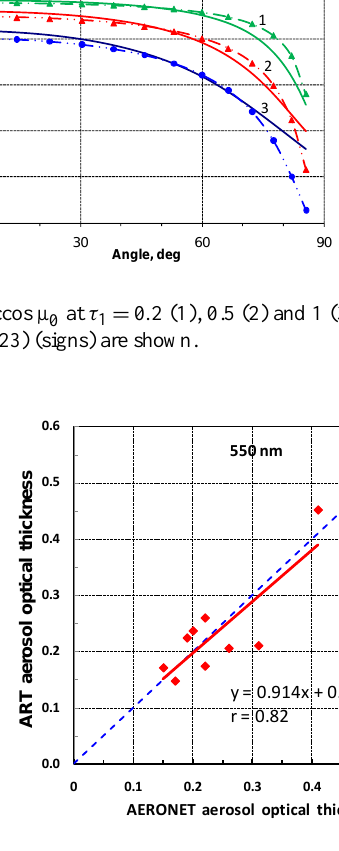
Fig. 9. The AOT retrieved with the ART code versus AERONET AOT at λ = 440nm